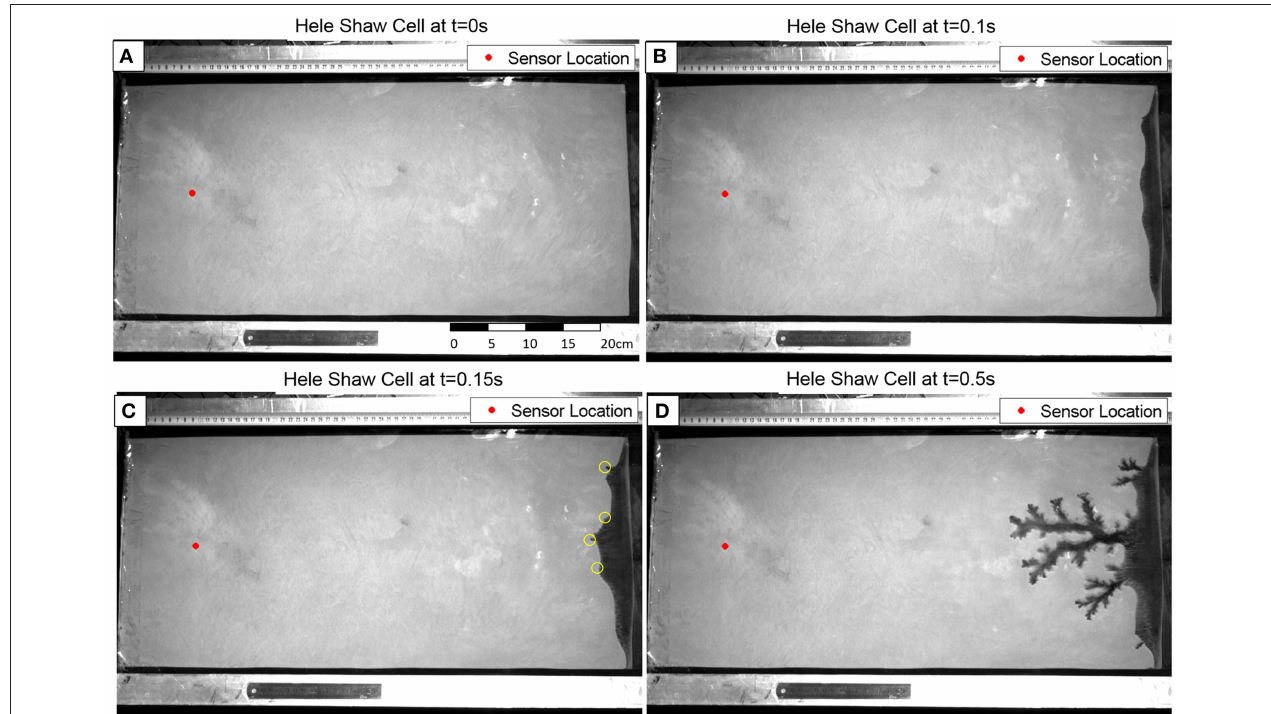
FIGURE 3 | Image of the Hele-Shaw Cell prior to injection (A), during quasi-homogenous compaction (B) and during channeling (C–D). Red dot shows the position of the acoustic sensor (accelerometer). Yellow circles in (C) represent the locations of the first finger-like carved formations.